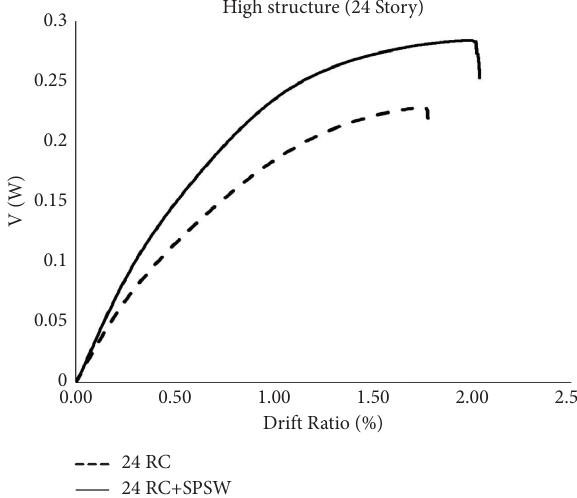
Figure 7: Result of nonlinear static analysis of high-rise structures.